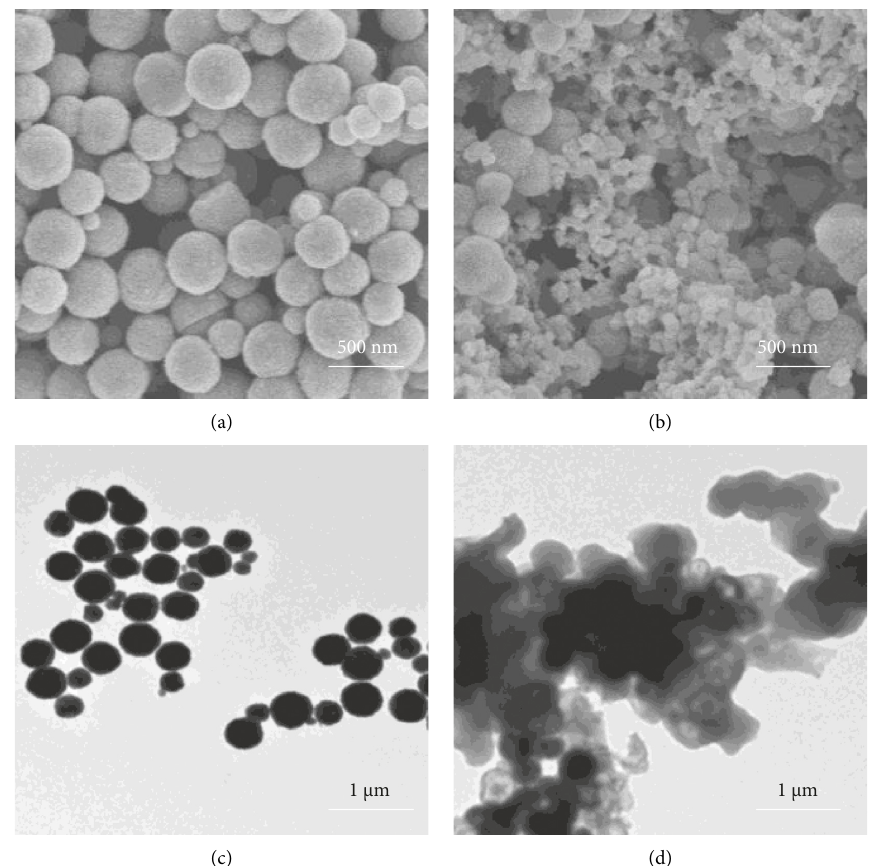
Figure 4: The SEM images of Fe 3 O 4 (a) and Fe 3 O 4 @SiO 2 -NH 2 -COP (b). The TEM images of Fe 3 O 4 (c) and Fe 3 O 4 @SiO 2 -NH 2 -COP